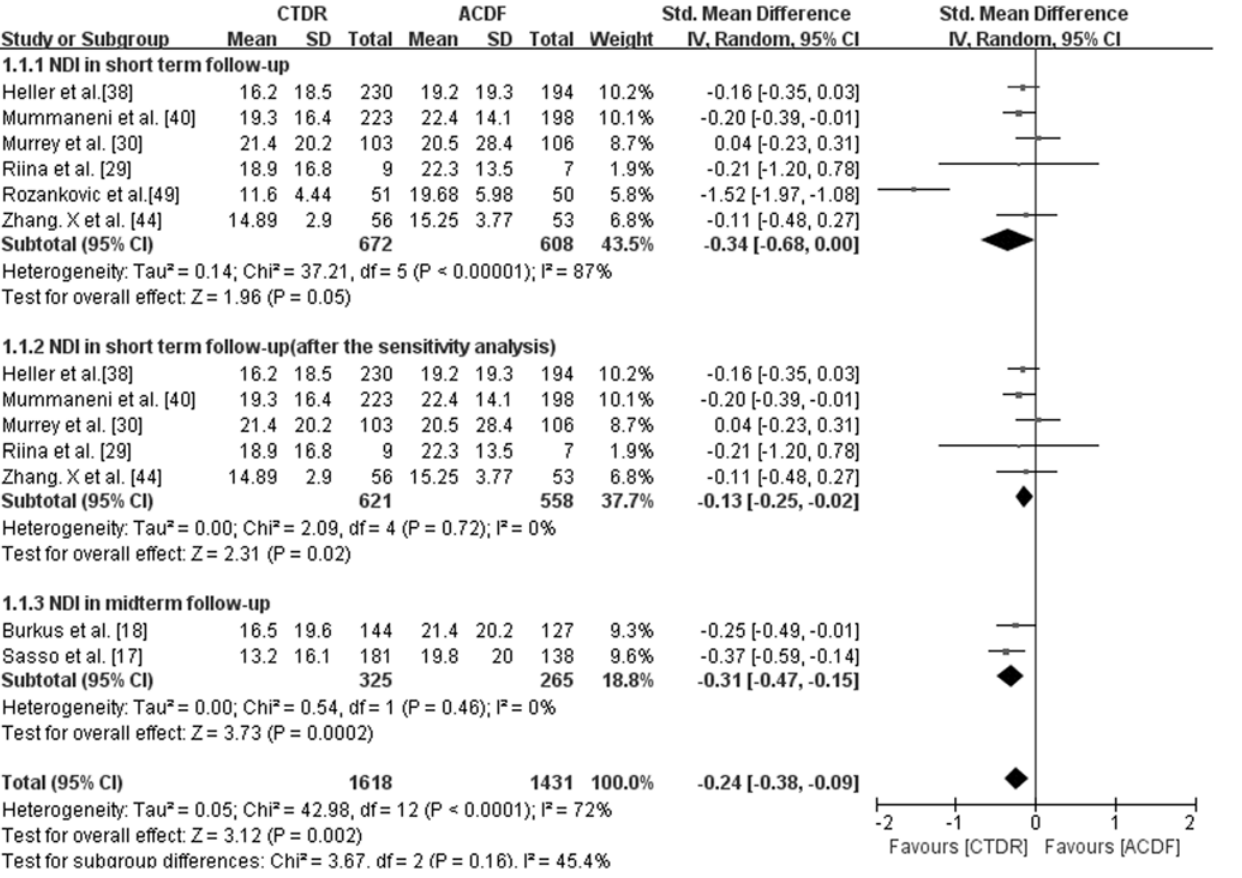
Fig 3. Comparison of NDI scores between the cervical total disc replacement (CTDR, experimental) group and the fusion (ACDF, control) group. IV = inverse variance, CI = confidence interval, and df = degrees of